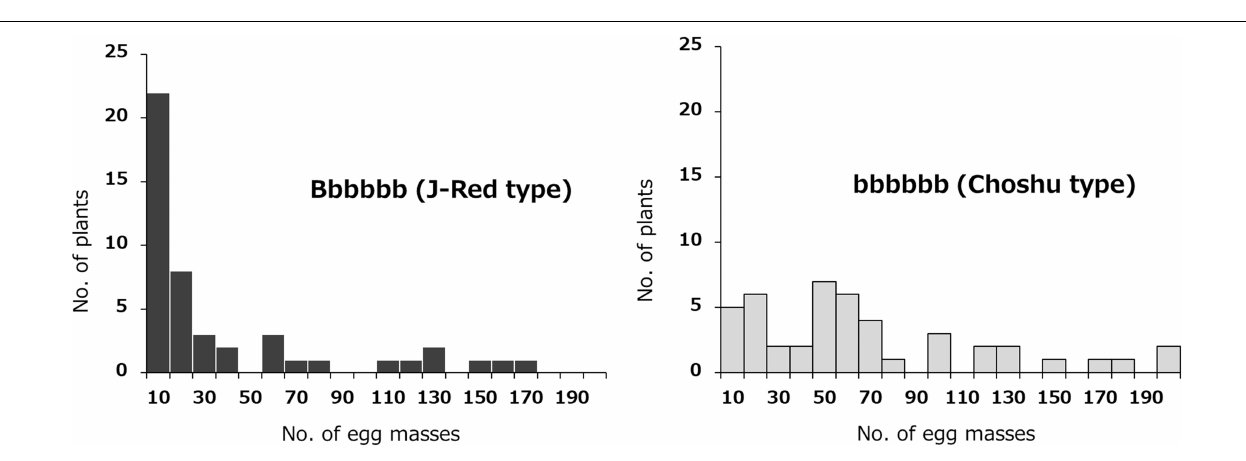
FIGURE 4 | Frequency distribution of the mean number of egg masses on F 1 lines grouped by genotype, based on the Chr03_18847788 SNP. Histograms with black and light gray indicate J-Red and Choshu genotype plants, respectively.